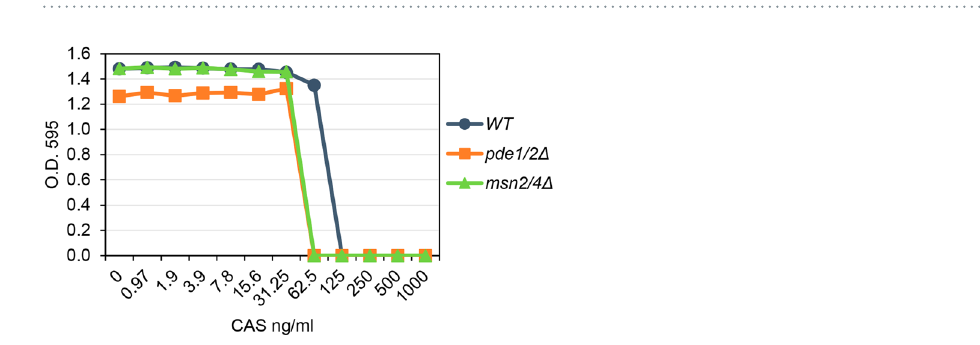
Figure 5. Intracellular cAMP and Ras2-GTP levels decrease in cells treated with caspofungin. ( a ) Wild-type (WT) was grown in YPD medium in the absence or presence of CAS during 2 h for cAMP quantification. The ras2 Δ mutant was included as control. Relative cAMP levels are shown (wild-type strain = 100%) from three independent experiments. Statistical analysis was carried out using a two-tailed, unpaired, Student’s t-test to analyse differences between the wild-type strain treated with CAS or the ras2 ∆ mutant versus the wild-type strain without treatment: 0.01 ≤ * p ≤ 0.02. ( b ) Whole cell extracts were prepared from early log phase cells of the wild-type (WT) strain grown in YPD in the presence or absence of CAS for 2 h, the ras2 Δ strain grown in YPD and WT cells grown in SC medium transferred to SC-D for 2 h (conditions of glucose starvation, C-starved). Active Ras2 (Ras2-GTP) was pulled down using GST-RBD bound to glutathione beads. The levels of Ras2-GTP (in the pull-down samples) as well as total Ras2 (in the whole cell extracts) were detected by immunoblotting with the anti-Ras2 antibody. A representative Western blot is shown. The mean and SD from three independent experiments of the ratio Ras2-GTP/total Ras2 relative to the wild-type sample (ratio = 1) is presented in the lower panel.